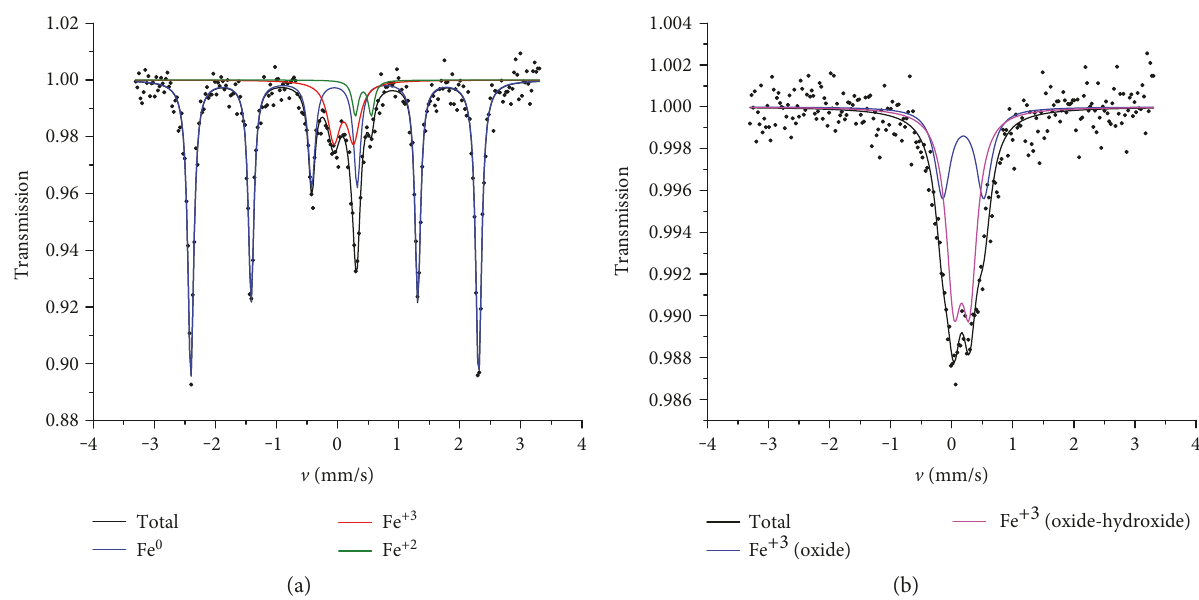
Figure 3: Mossbauer spectroscopy of the Fe nanoparticles (a) before the phenolphthalein degradation experiments and (b) after the phenolphthalein degradation experiments.